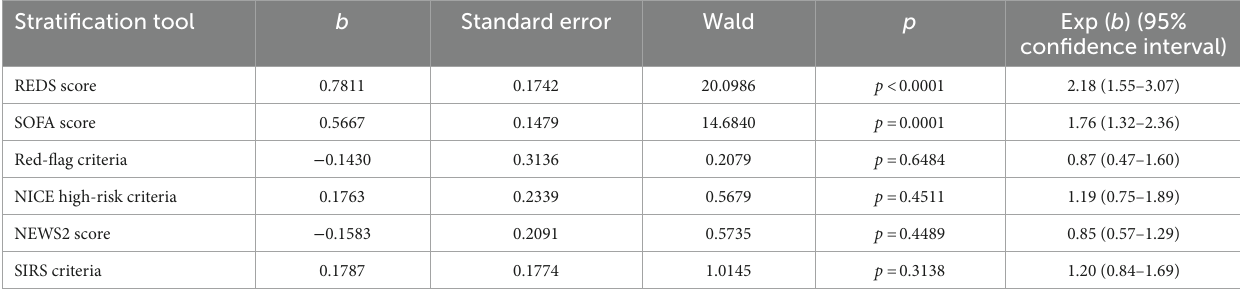
TABLE 6 Cox proportional hazard regression of the six risk-stratification tools in the population with specified * comorbidities. Stratification tool b